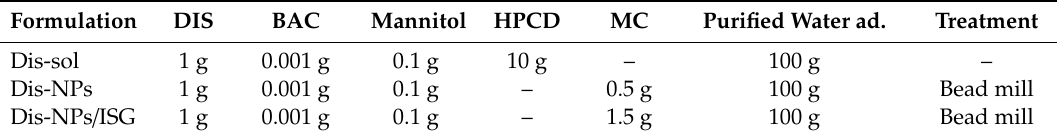
Table 1. Composition of ophthalmic disulfiram (DIS) formulations. Formulation DIS BAC Mannitol HPCD MC Purified Water ad. Treatment Dis-sol 1